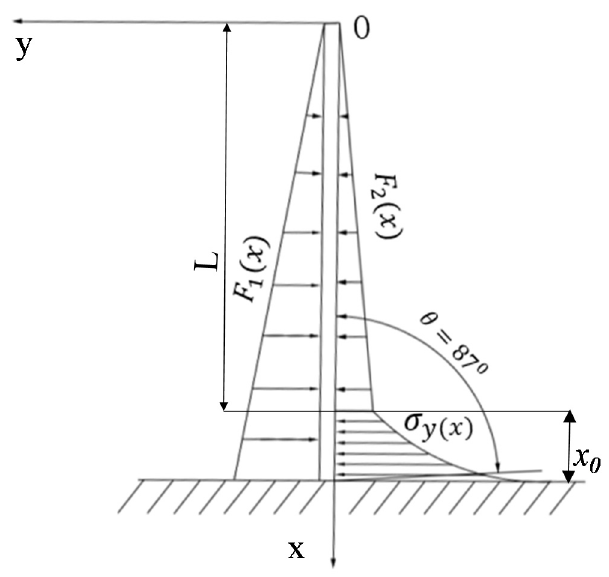
Figure 6. Mechanical model of the “steeply inclined suspended roof structure”.